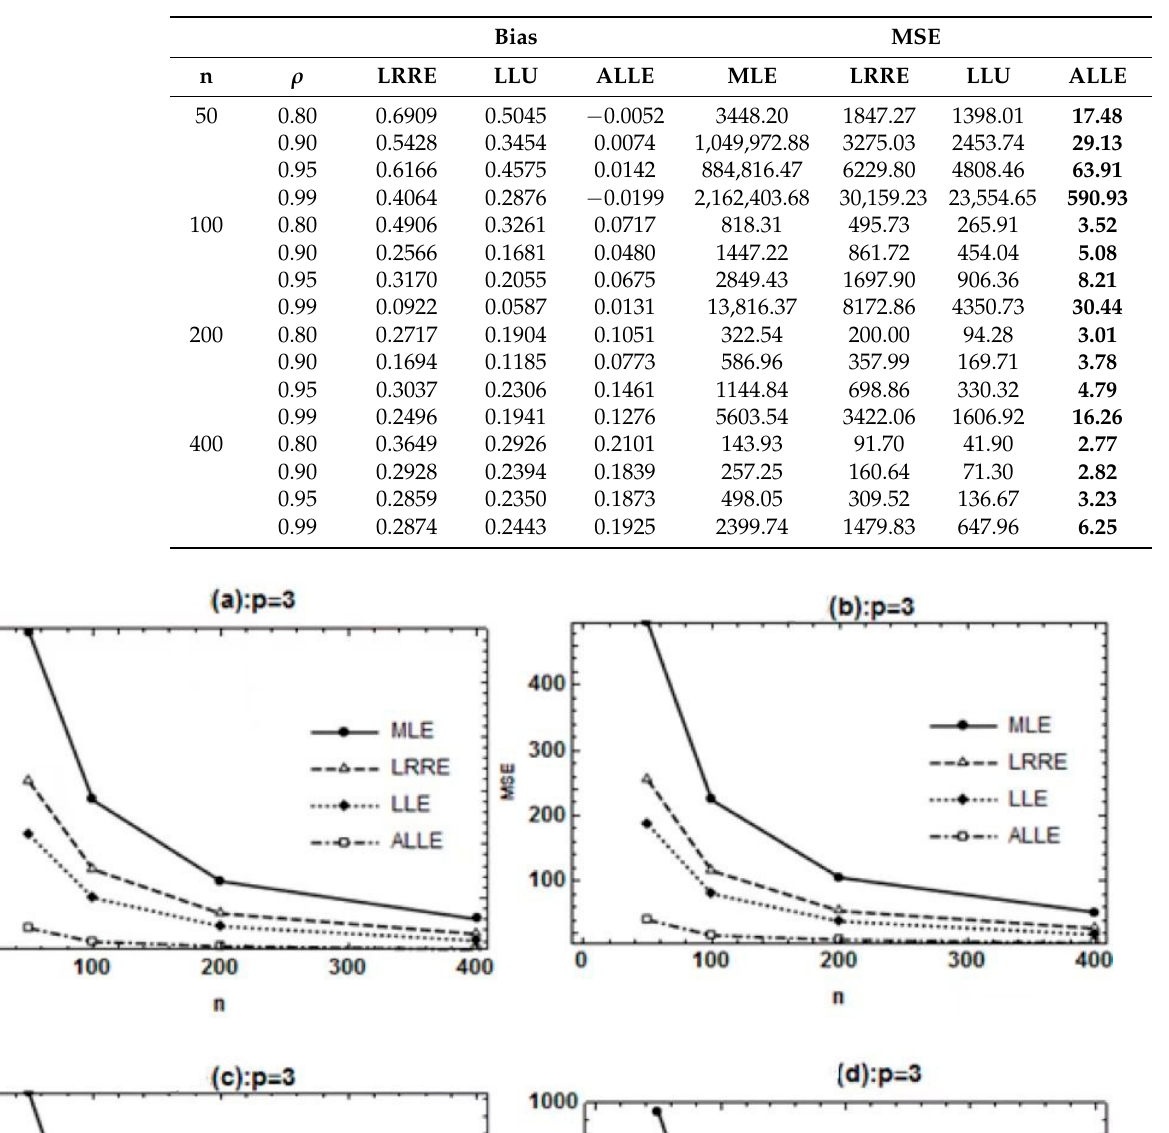
Table 3. Bias and MSE values of the estimators for p = 12.